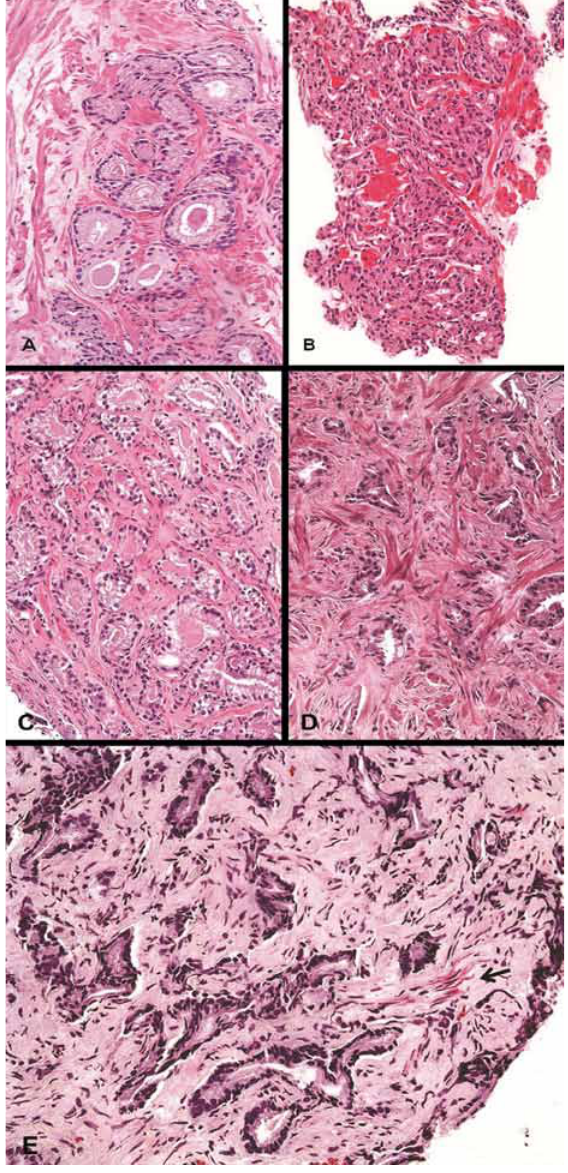
Figure 1 - (A) Grade 0 (absent reactive stroma): Gleason score 6 adenocarcinoma; (B) Grade 0 (absent reactive stroma): Gleason score 7 adenocarcinoma; (C) Grade 1 (slight reactive stroma); (D) Grade 2 (moderate reactive stroma); (E)